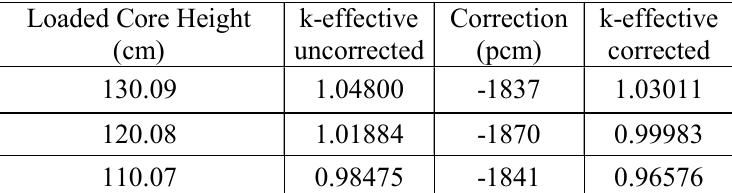
Table II. WIMS Results for the HTR-10 Benchmark